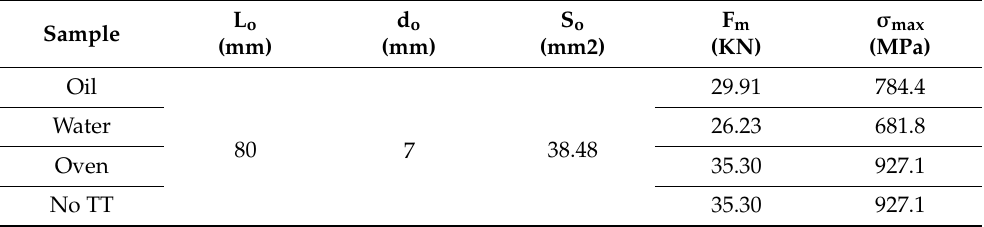
Table 2. Tensile test parameters .